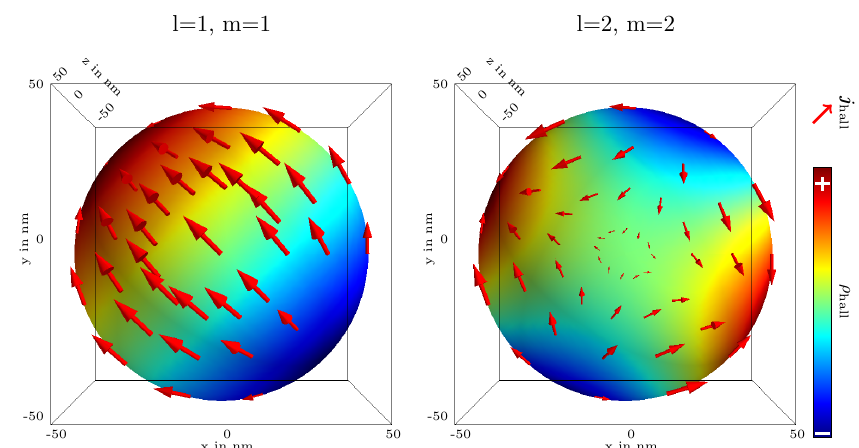
Figure 3: Hall currents (real part) of the electric l = 1, m = 1 / l = 2, m = 2 mode (vector plot) and the corresponding oscillating charges (color coded) for a TI sphere ( R = 50nm, ε = − 1, Θ = π ) embedded in vacuum at ħ h ω = 2eV. Note that the induced hall charges and currents are coupled by a continuity equation. The plotted quantities stem from the axion related terms of the boundary conditions (Eq. (23) and Eq. (24)) vanishing for topological trivial